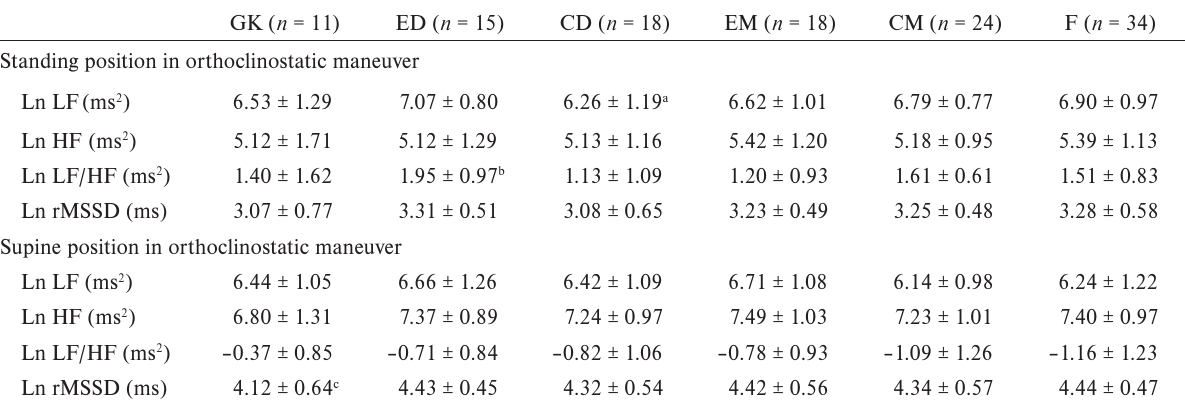
Values of SA HRV according to playing positions (mean ± SD; N = 120) GK ( n = 11) Standing position in orthoclinostatic maneuver